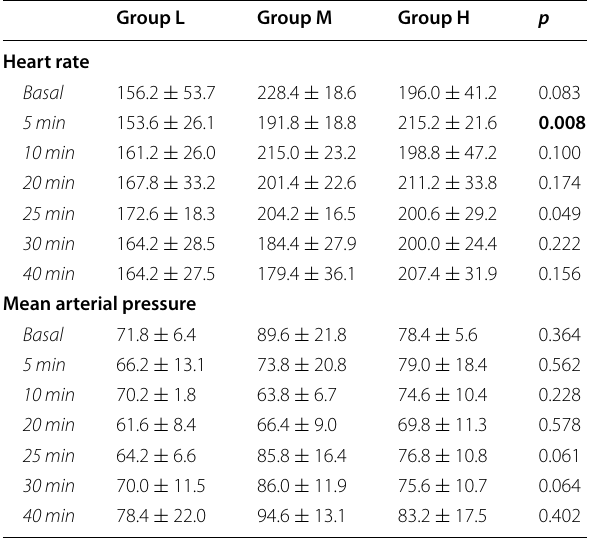
Table 1 Presentation of mean heart rate and mean arterial pressure recordings (mean SD) for three different ± sugammadex dose groups through experiment by intervals.